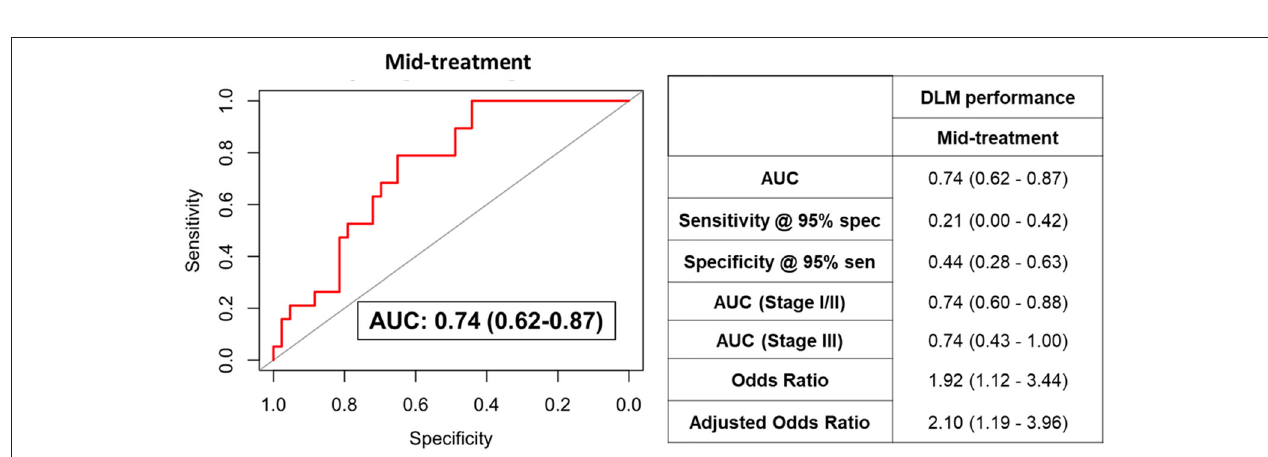
FIGURE 2 | ROC curve for the DLM for distinguishing TNBC patients that went on to have RCB-II/III following NACT from those that had RCB-0/I. Table provides tabulated performance estimates of the DLM. † Age and stage were included as covariables in adjusted odd ratios.